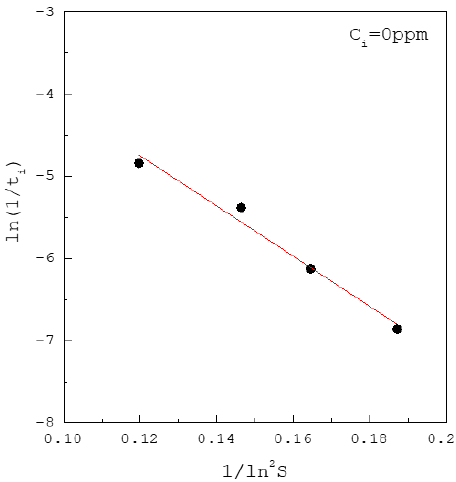
Figure 3. The induction time data of calcium oxalate at 37 °C fitted to Equation (4).